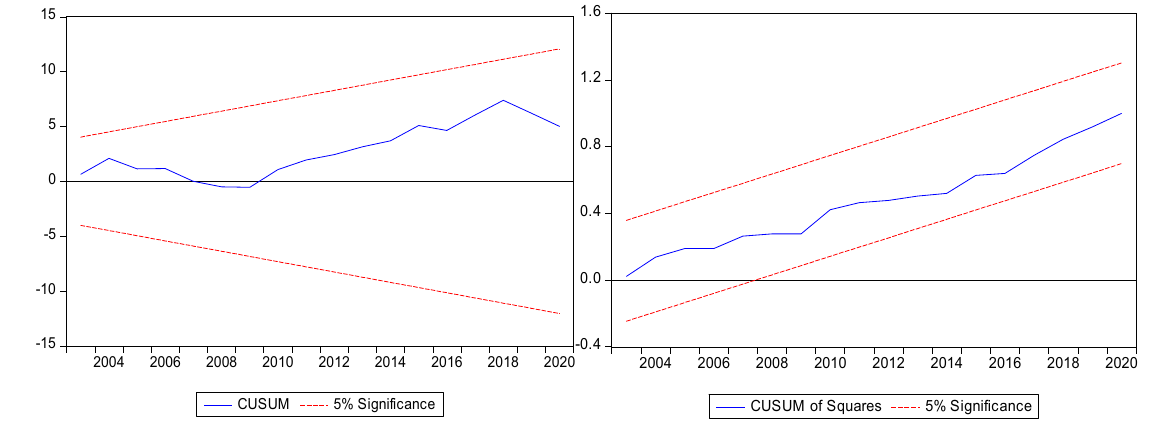
Figure 2. Stability Test of Cusum and Cusum of squared plots.